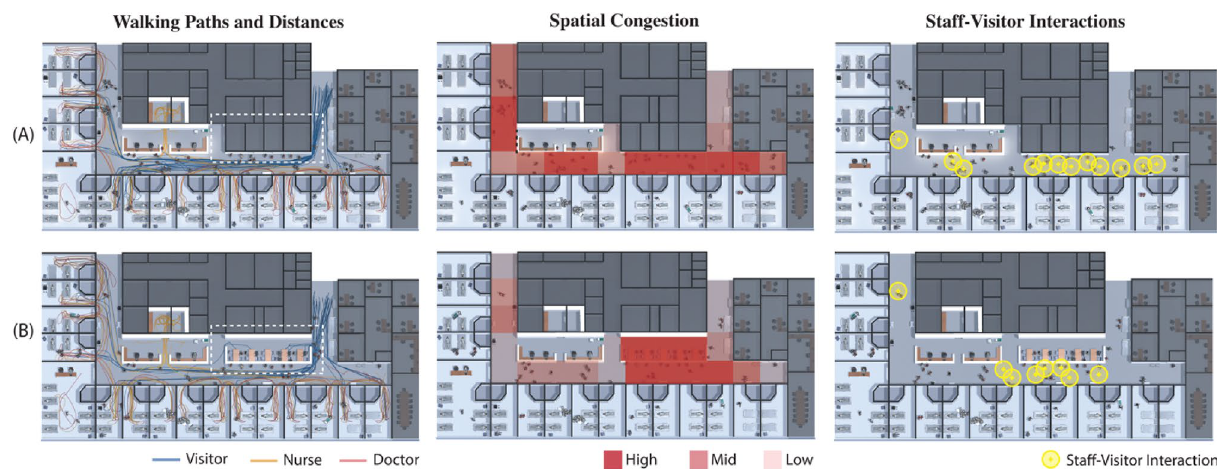
Figure 6. Comparative evaluation of the impact of two design strategies on the inhabitants’ behavior. The design difference relates to the presence (Design A) or absence (Design B) of a dayroom (marked with a white dotted line on the floorplan) where patients and visitors can gather to engage in social interactions. Results indicate that the presence of a dayroom reduces people density in corridors and leads to fewer interruptions for the medical staff involved in patient care activities. Figure adapted from 143